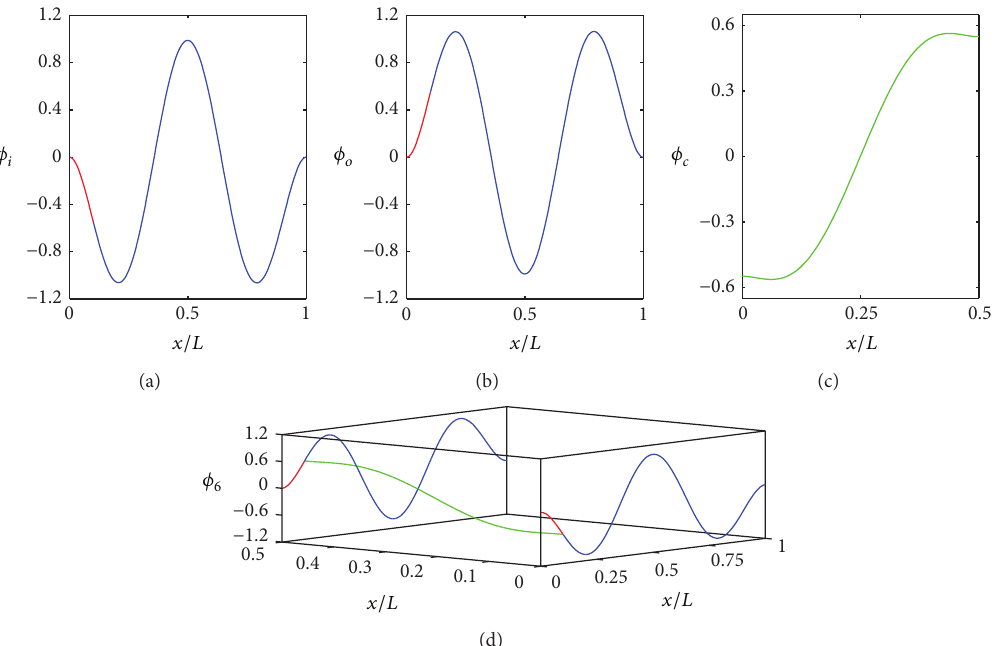
Figure 7: Sixth mode shape of the filter: (a) input, (b) output, (c) coupling beams, and (d) combination of (a), (b), and (c).